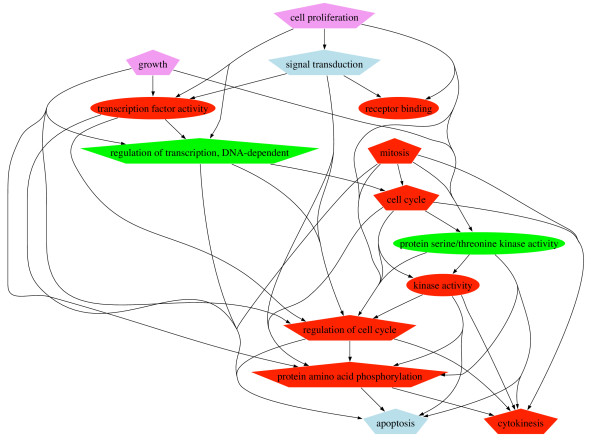
A selective part of the inter-dependent terms network for the Down cluster. Shape: ellipse = function, polygon = process. Annotations: GOA (Evidence), PUB (Literature) and DEP (Associative relations). Color: Venn categories, red = GOA+PUB+DEP, green = GOA+DEP, lightblue = PUB+DEP, violet = DEP. Arrows indicate the way the dependence was found in our associative database.